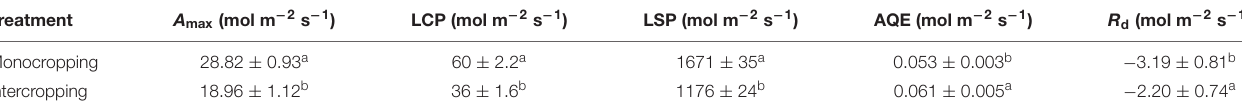
Mean values ± SE from five replicates, and different letters indicate statistical difference significance at P < 0.05 among the treatments by Duncan’s multiple range tests. A max , light-saturated net photosynthetic rate; LCP, light compensation point; LSP, light saturation point; AQE, apparent quantum efficiency; R d , dark respiration rate.